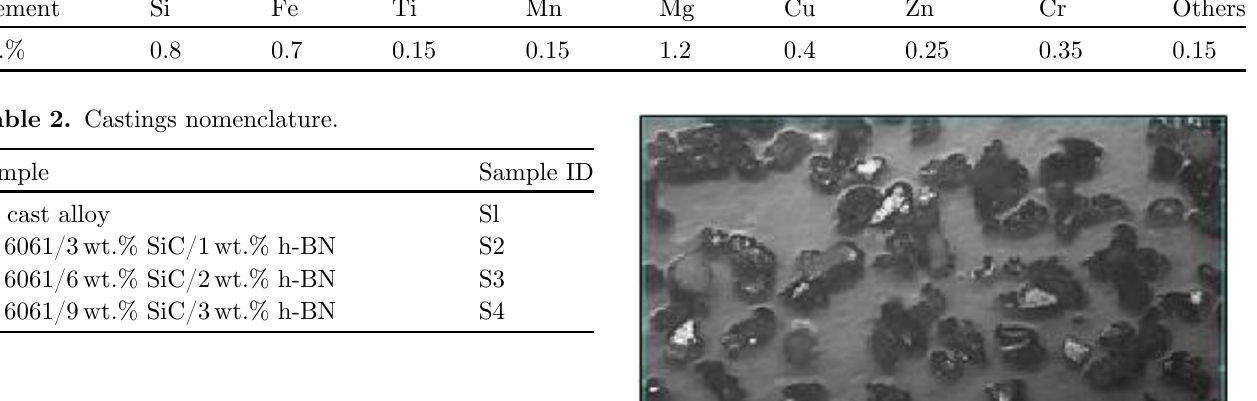
Table 1. Chemical elements in as received Al6061. Element